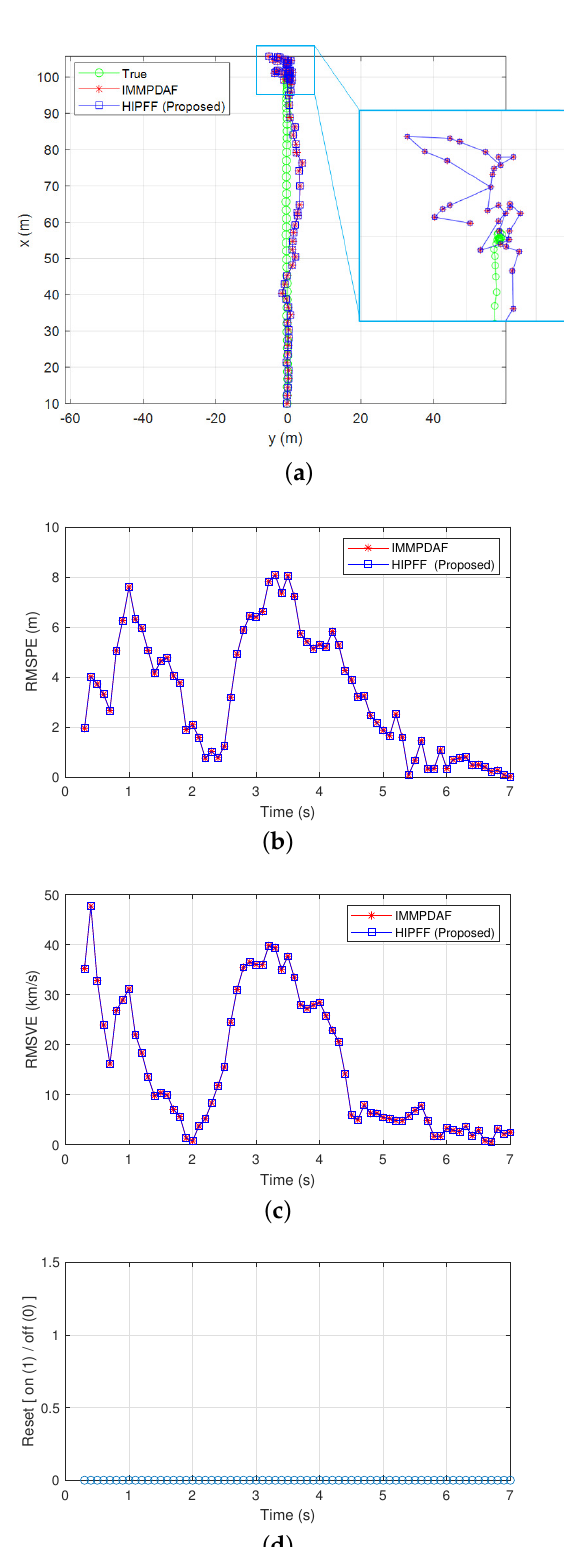
Figure 2. Simulation results of a successful track case: ( a ) true and estimated positions; ( b ) root-mean- square position error (RMSPE); ( c ) root-mean-square velocity error (RMSVE); and ( d ) reset